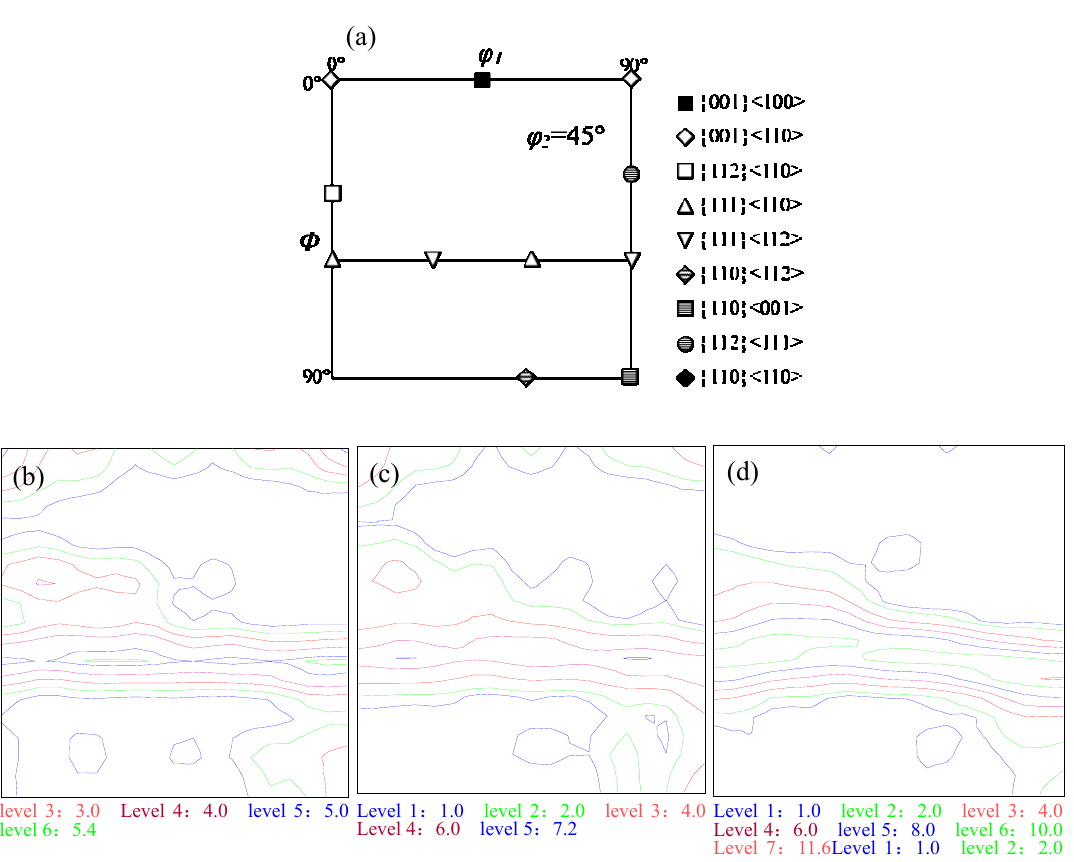
Figure 4. Orientation Distribution Function (ODF) measured by X-Ray diffractometer (XRD): ( a ) most important orientations in bcc materials in the φ 2 = 45° section; ( b ) start of recrystallization, sample 6; ( c ) nucleation and growth, sample 7; ( d ) end of recrystallization, sample 8.